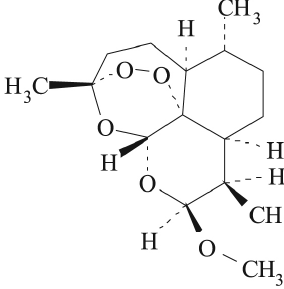
FIGURE 1 – Chemical structure of